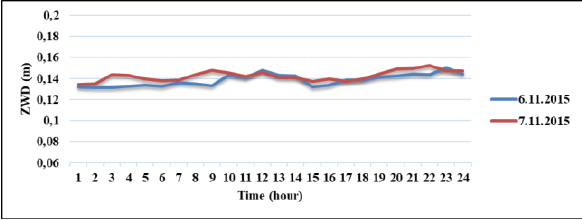
Figure 12. PM 10 time series of Zonguldak. A difference of 5 μg/m 3 was observed at the average PM 10 value between 08-09 February 2015, whereas an average difference of 2 mm was calculated for the wet zenith delay values. Figure 13 shows ZWD values on 08-09 February